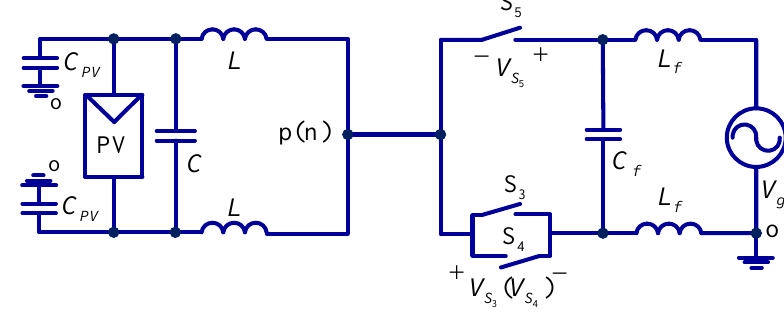
Figure 6. Circuit model of CH5 in new mode.